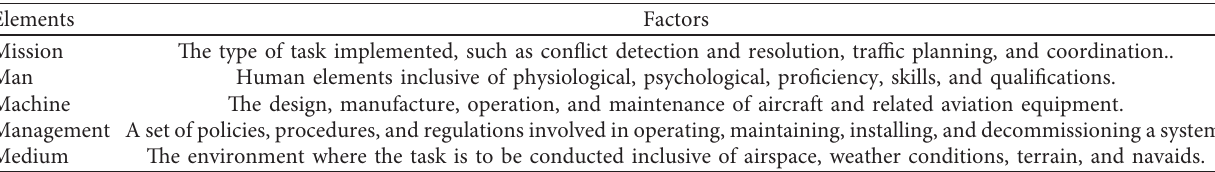
Table 2: System change analysis process.